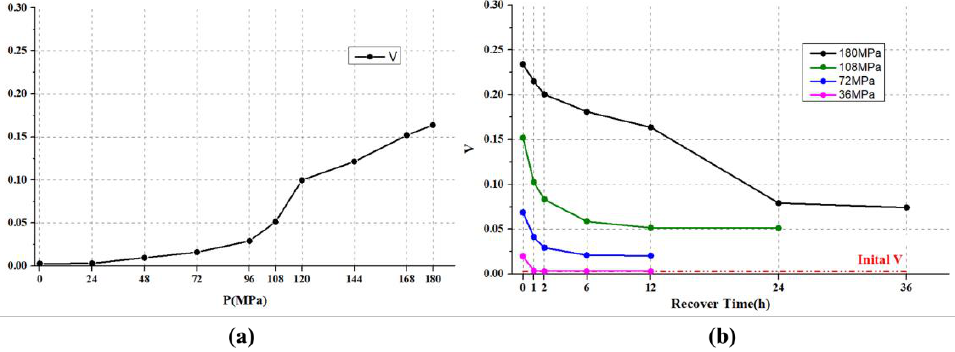
Figure 6. ( a ) V for different pressurization pressures; ( b ) V for different recovery times.